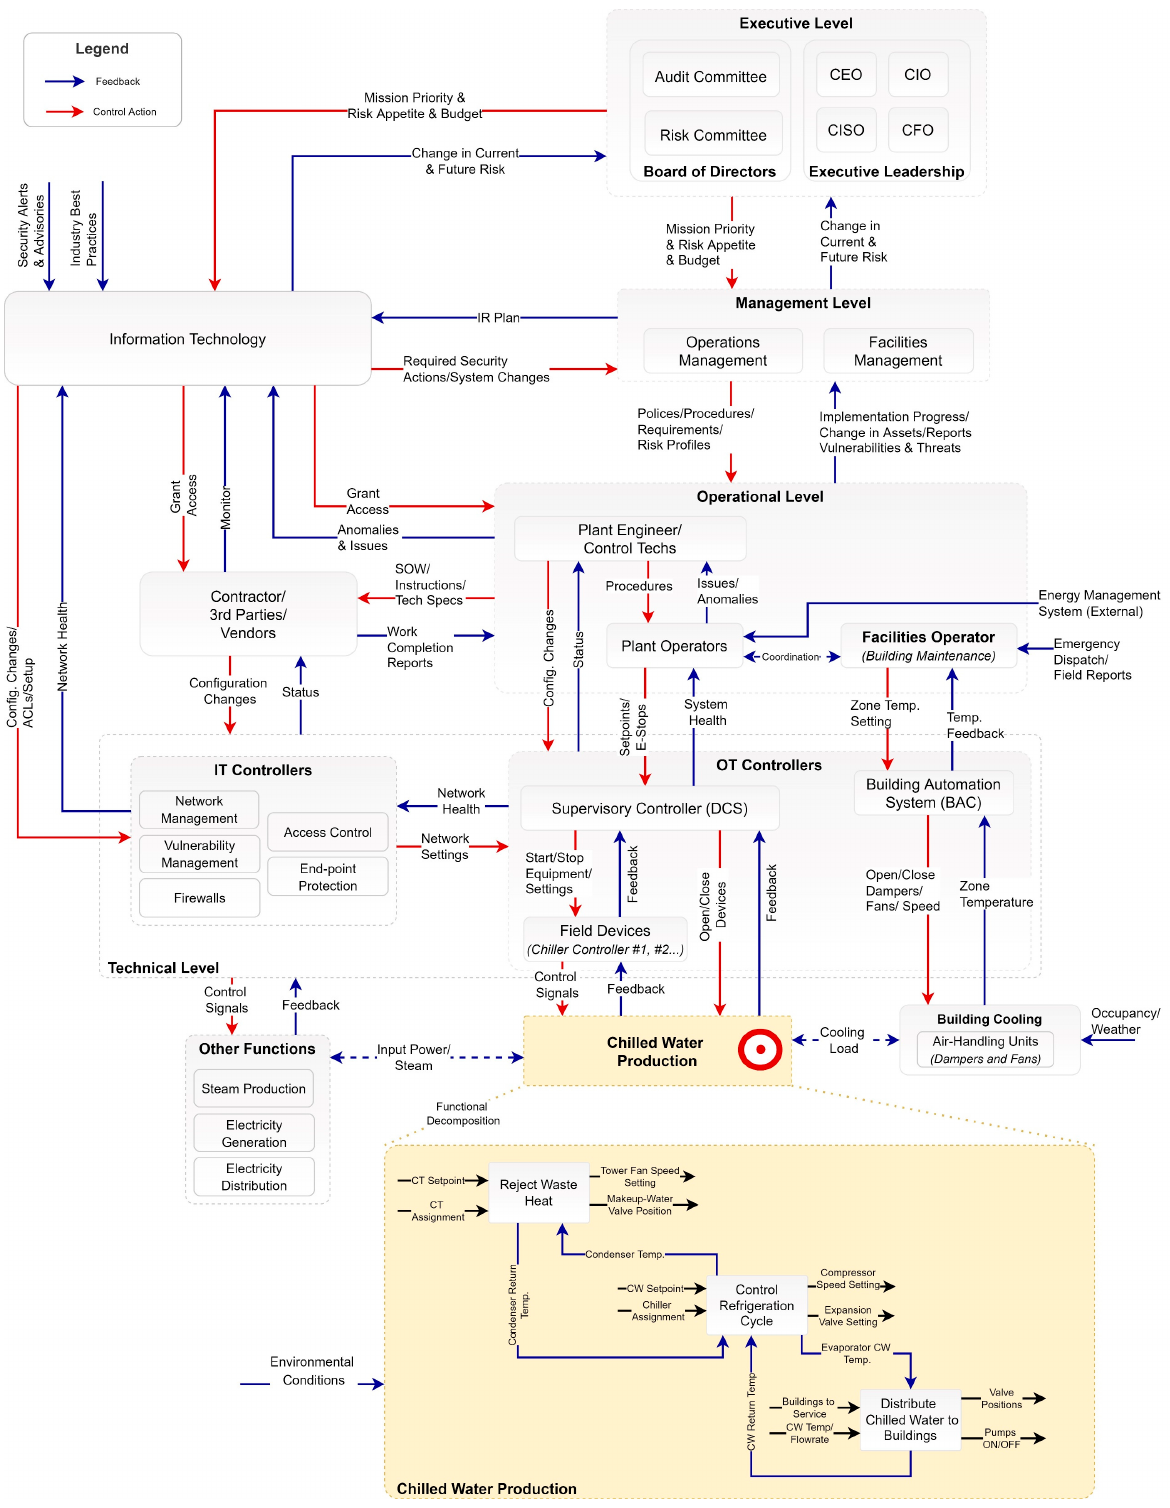
Figure 3. Detailed Hierarchical Functional Control Structure for the Chiller Plant.